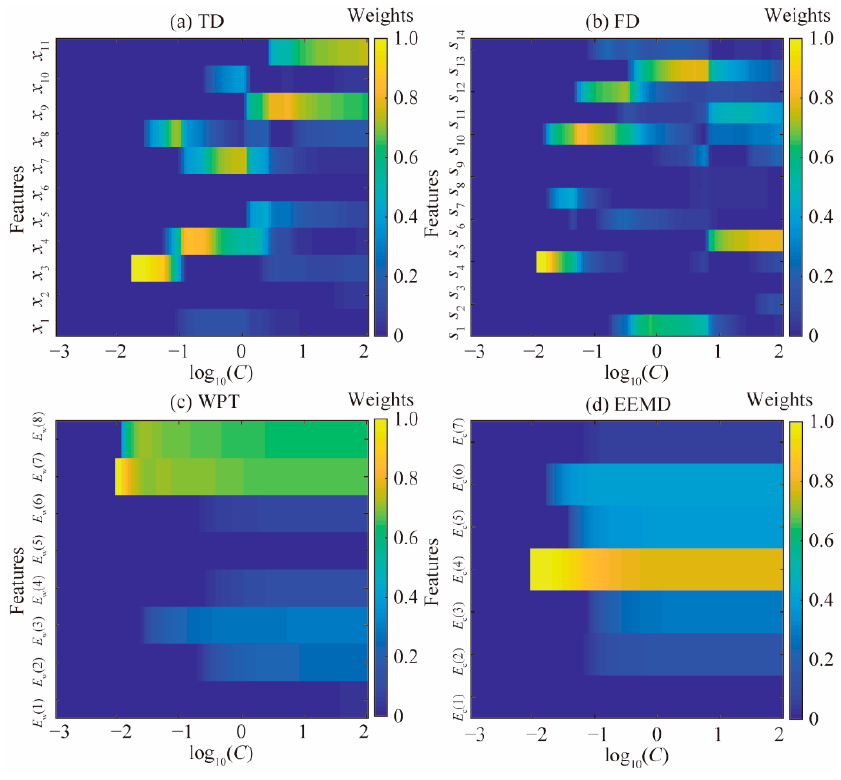
Figure 10. Weight variations of multiple features. ( a ) TD; ( b ) FD; ( c ) WPT; ( d ) EEMD.